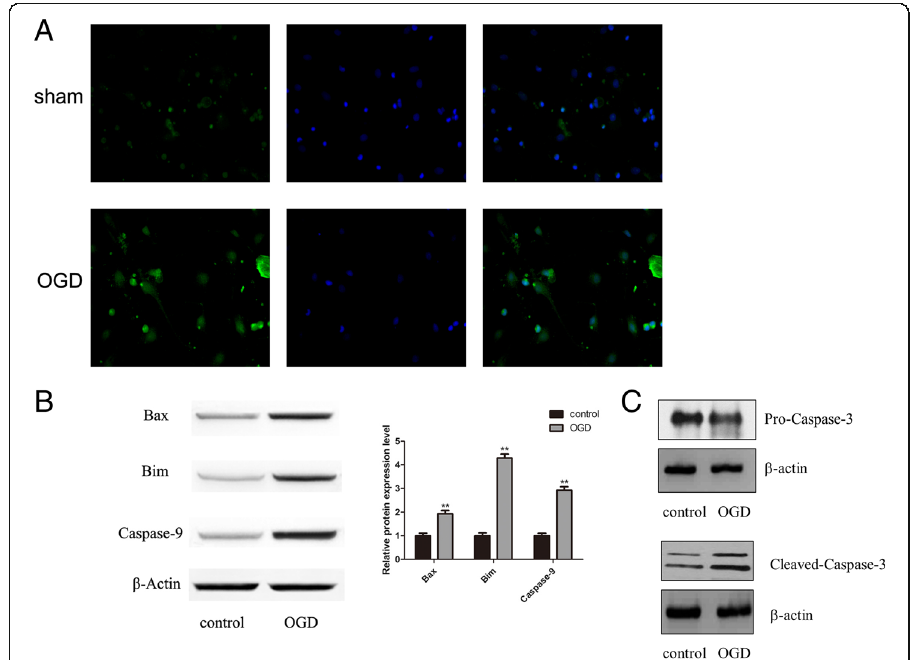
Fig. 3 OGD-induced neuronal apoptosis. a , TUNEL staining of cells in control and OGD groups. Data are representative of three independent experiments. b , The expression levels of pro-apoptotic proteins Bax, Bim and caspase-9 were analyzed by western blot. c , The expression levels of pro-apoptotic proteins, pro-caspase-3 and cleaved-caspase-3 were analyzed by western blot. Representative blots of three independent experiments are shown in b and c . Densitometry analysis was expressed as means ± SD. (** P <0.01 vs. control group)